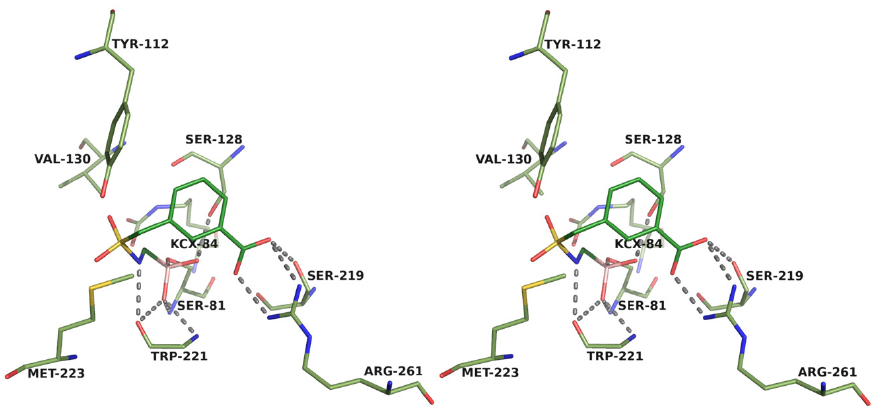
Figure 4. Stereoview of the OXA ‐ 24/40 complex with CR167 . For contrast, the carbon atoms of CR167 are colored forest green. Hydrogen bonds (between 2.6 and 3.2 Å) are indicated with gray dashed lines.